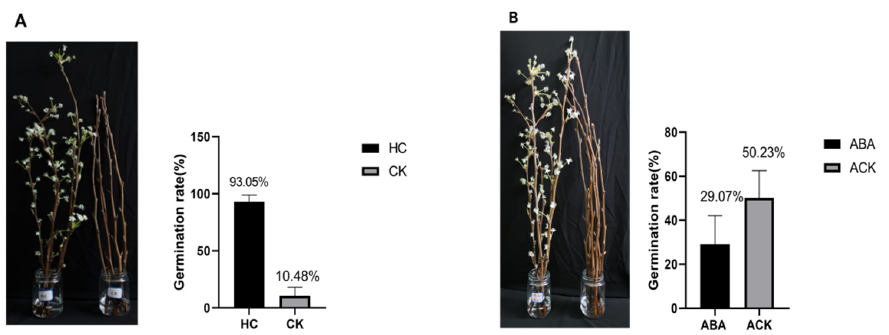
Figure 4. ( A ) Germination results response to 1% HC treatment. Comparison of germination results, the left side is the HC treatment group and the right side is the control group; ( B ) Germination results response to 150 mg/L ABA treatment. Comparison of germination results, the right side is the 150 mg/L ABA treatment group and the left side is the control group.